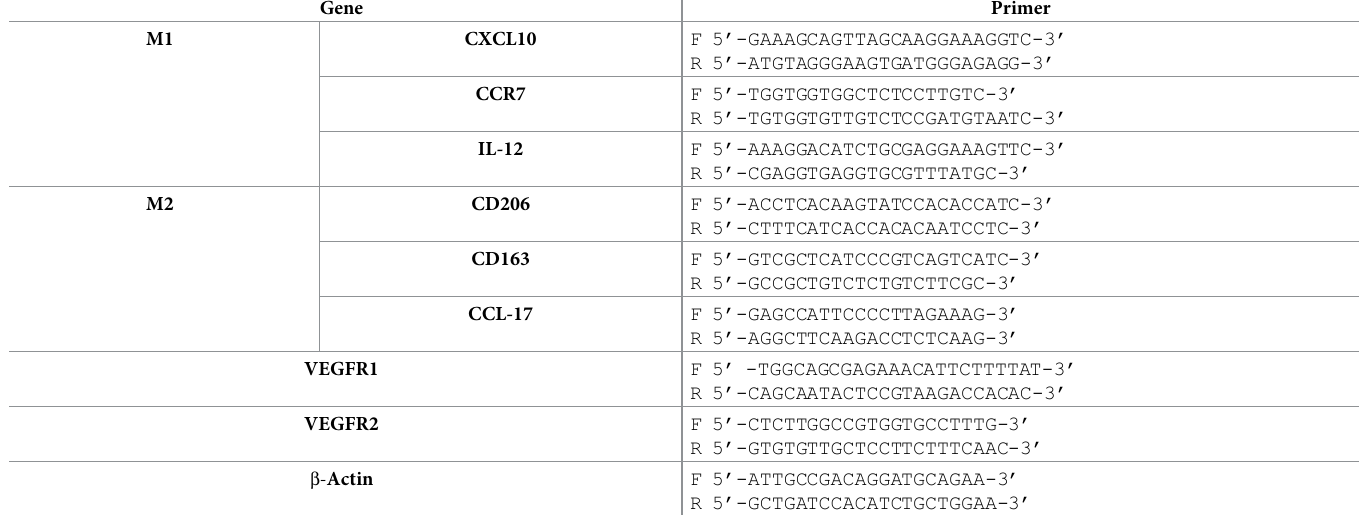
Table 1. Primers for quantitative real-time